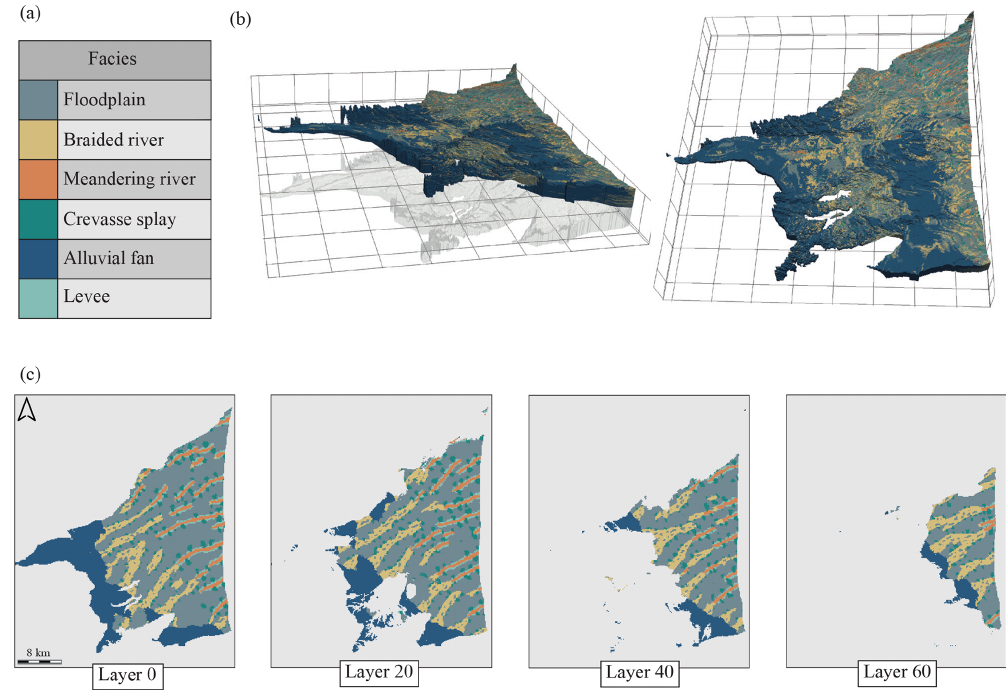
Figure 7. (a) The six simulated facies, (b) one 3D model of the simulations set, in the original 3D grid (left figure) and in the transformed grid (right figure). (c) Different z layers (horizontal sections extracted from the 3D transformed